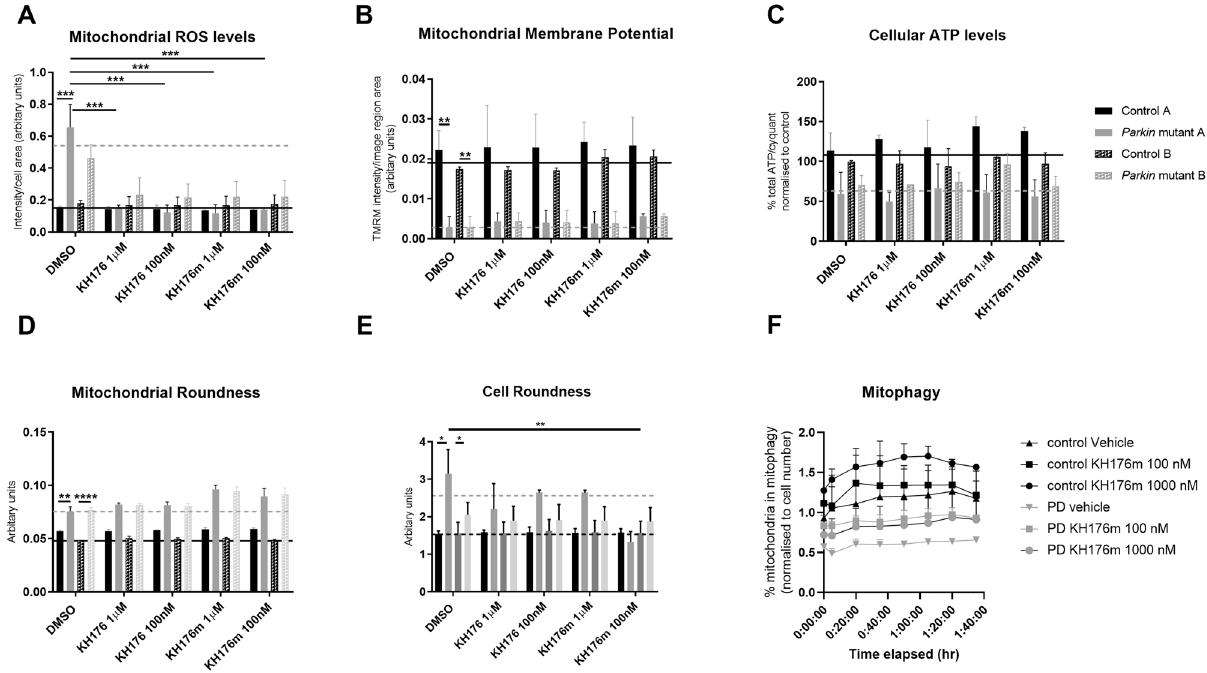
Figure 5. Treatment of dopaminergic iNeurons with KH176 and KH176m. ( A ) Mitochondrial ROS levels are significantly reduced with treatment of both KH176 and KH176m (n = 3 for each line presented, 2 way ANOVA with Sidaks multiple comparisons test ***p < 0.0001). ( B ) Mitochondrial membrane potential is significantly reduced in PRKN mutant patient neurons however treatment with KH176 and KH176m has no effect on mitochondrial membrane potential (2 way ANOVA with Sidaks multiple comparisons test **p = 0.0009 and 0.025 respectively). ( C ) Cellular ATP levels are reduced in PRKN mutant neurons however treatment with KH176 and KH176m has no significant effect. ( D ) Mitochondria are more round in PRKN mutant patient neurons compared to controls, again treatment with KH176 and KH176m has no effect (2 way ANOVA with Sidaks multiple comparisons test **p = 0.0048 and ****p = 0.0001 respectively). ( E ) shows cellular roundness is increased in PRKN mutant neurons; treatment with KH176m at 100 nM has a significant effect of reducing neuronal roundness, indicating the neurons are more elongated and similar in morphology to the controls (2 way ANOVA with Sidaks multiple comparisons test *p = 0.018 and **p = 0.0045 respectively). For ( A )–( E ) the black dotted line shows mean vehicle treated for controls and grey dotted line mean vehicle treated for PRKN , n = 3 for each line. Two way ANOVA with Sidaks multiple comparisons test used. ( F ) Basal mitophagy is reduced in PRKN mutant A (grey triangles) compared to control A (black triangles); treatment with KH176m at both 100 nM (squares) and 1000 nM (circles) concentrations increase basal mitophagy rates in both control A and PRKN mutant A (n = 2 for each line presented, 2 way ANOVA with Sidaks multiple comparisons test. P values described are for effect across multiple time points from 2 way ANOVA, control vehicle vs